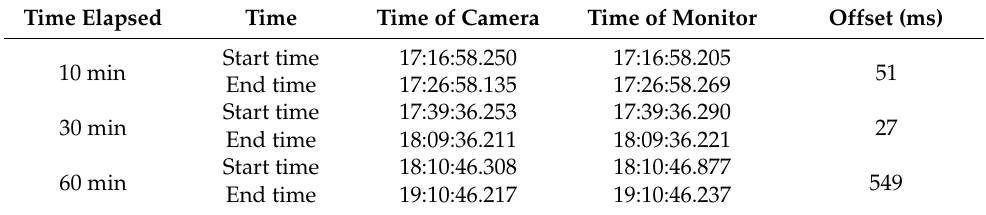
Table A3. Meta-data injection to ensure the video is treated as per clock of physiological signal, as a sample.